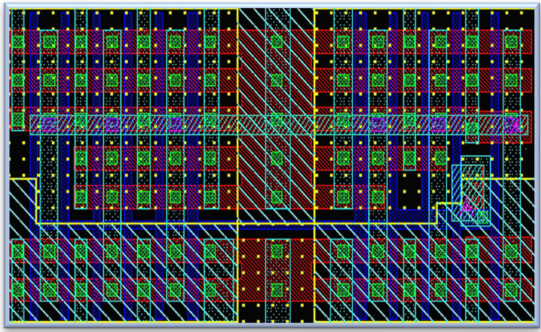
Figure 3. The layout of abacus-type inverters of the time-delay